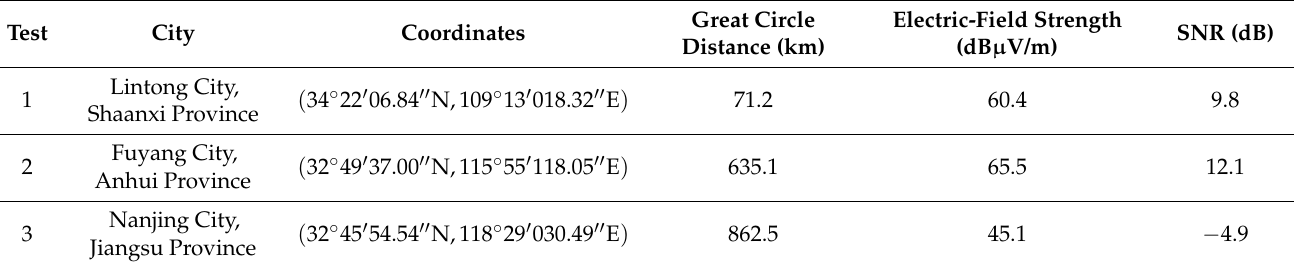
Table 3. Information of the three test sites.